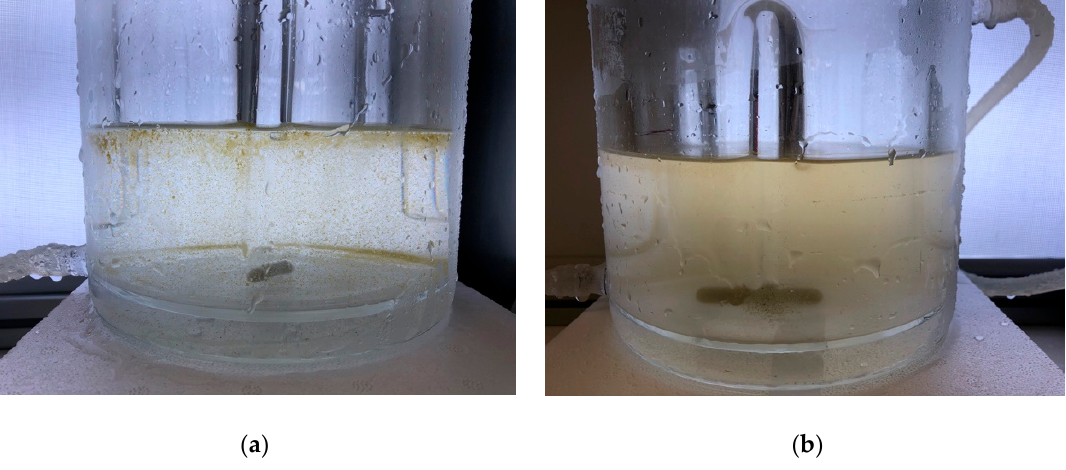
Figure 1. ( a ) Phaeocystis antarctica ; ( b ) Prorocentrum sp.